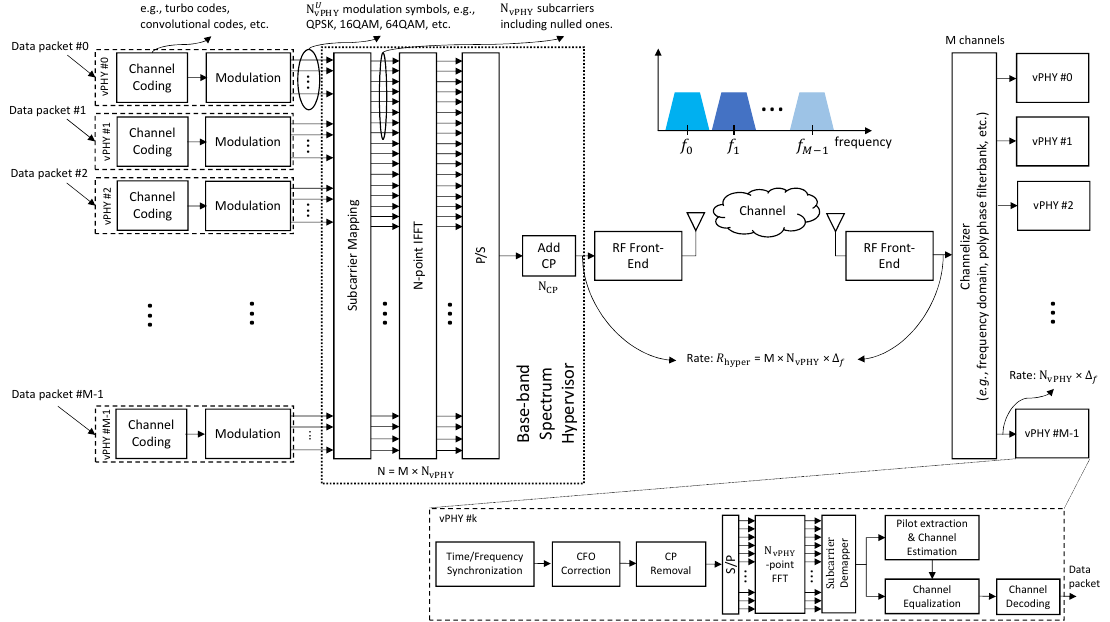
Figure 4. Architecture of the proposed baseband wireless